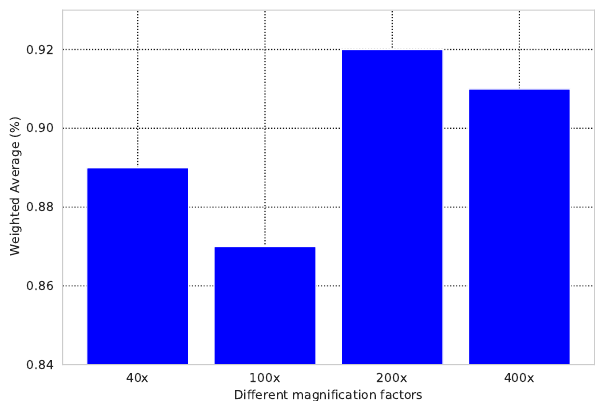
Figure 12. Weighted average accuracy